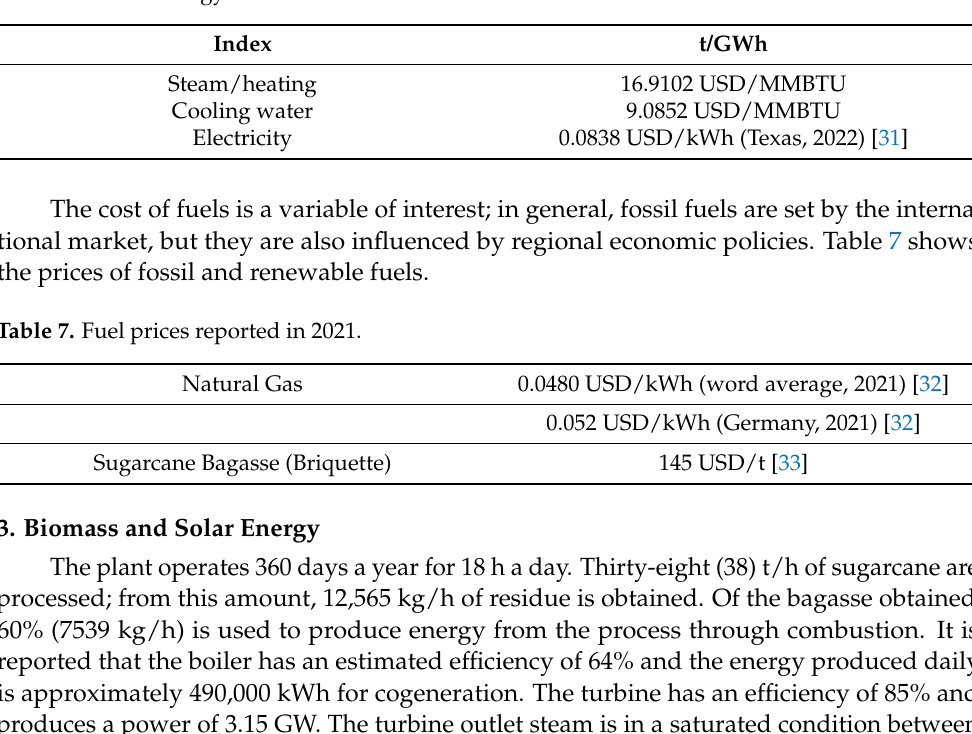
Table 6. Cost of energy services.